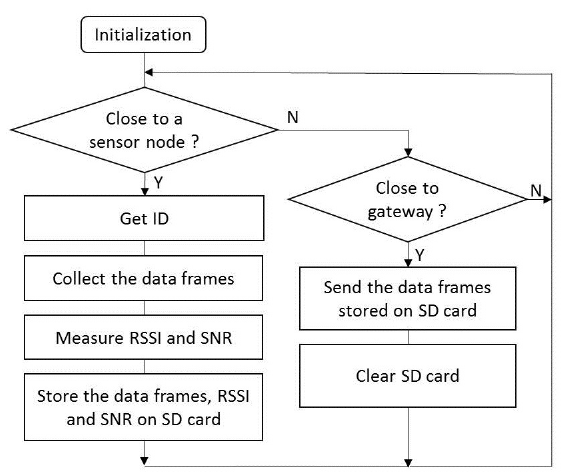
Figure 6. Diagram of the program in the collector node.